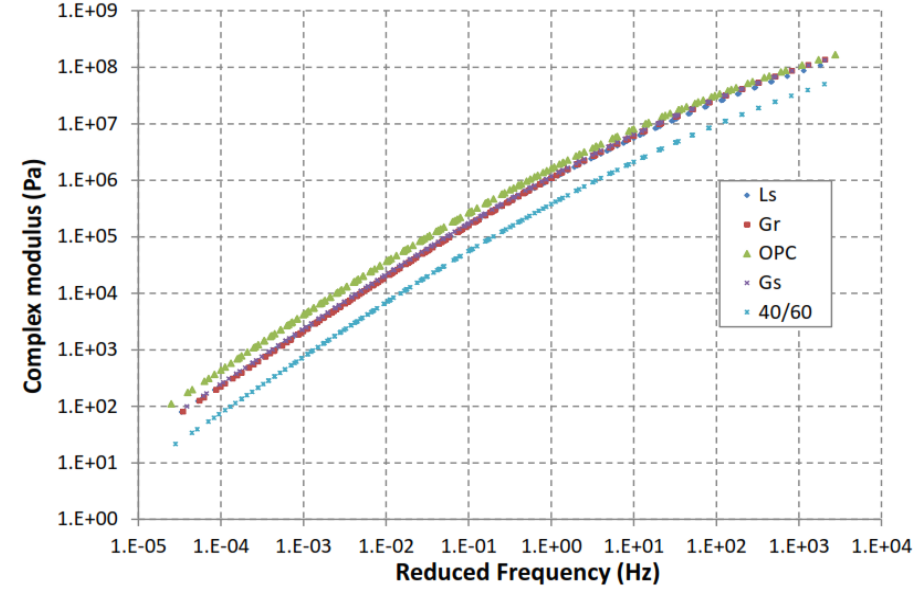
Figure 5. Complex modulus master curves.